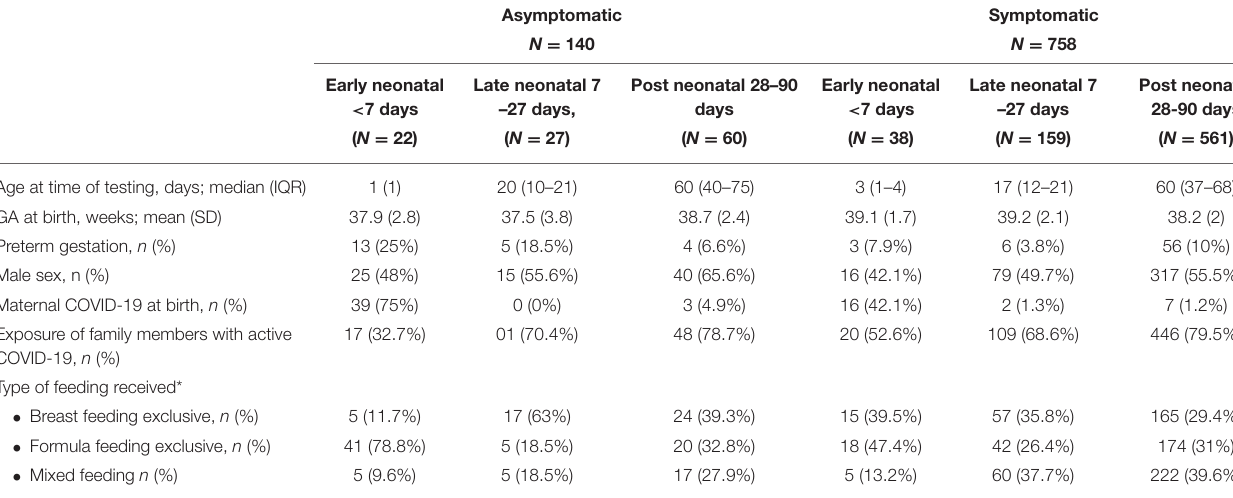
TABLE 2 | Asymptomatic and symptomatic patients grouped according to postnatal age.